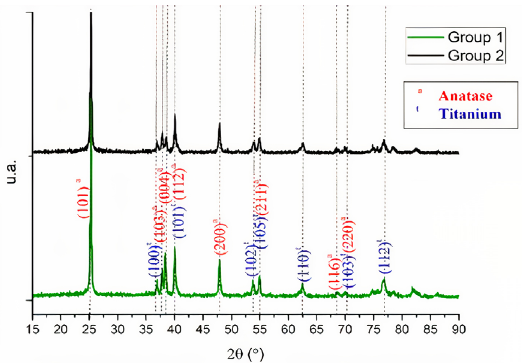
nanotube) and Group 2 2